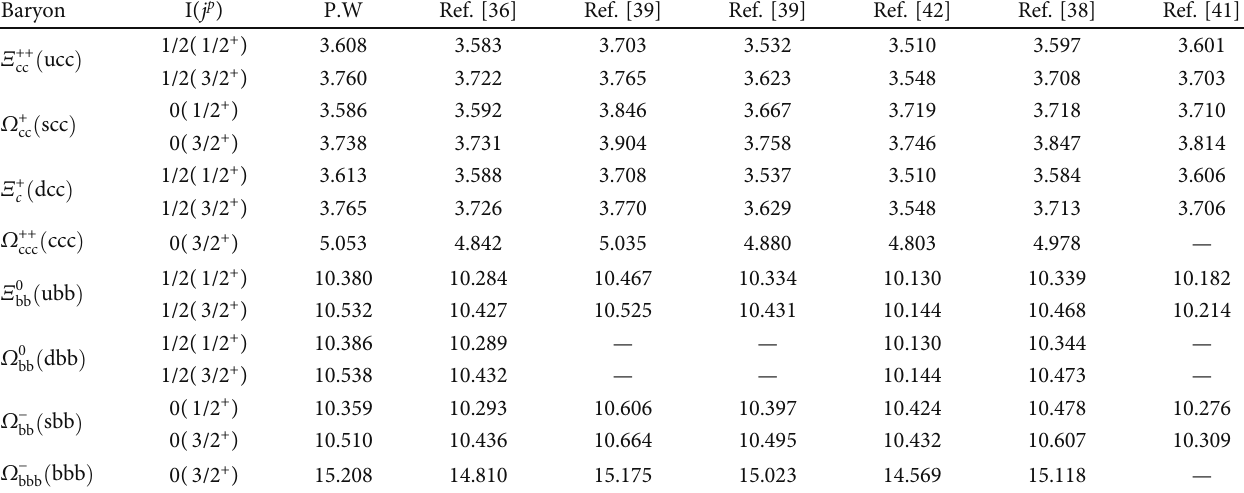
Table 8: Double and triple charm and beauty baryon masses in the ground state (masses are in GeV) at ( α = β = 0 : 39 ). Baryon I( j p